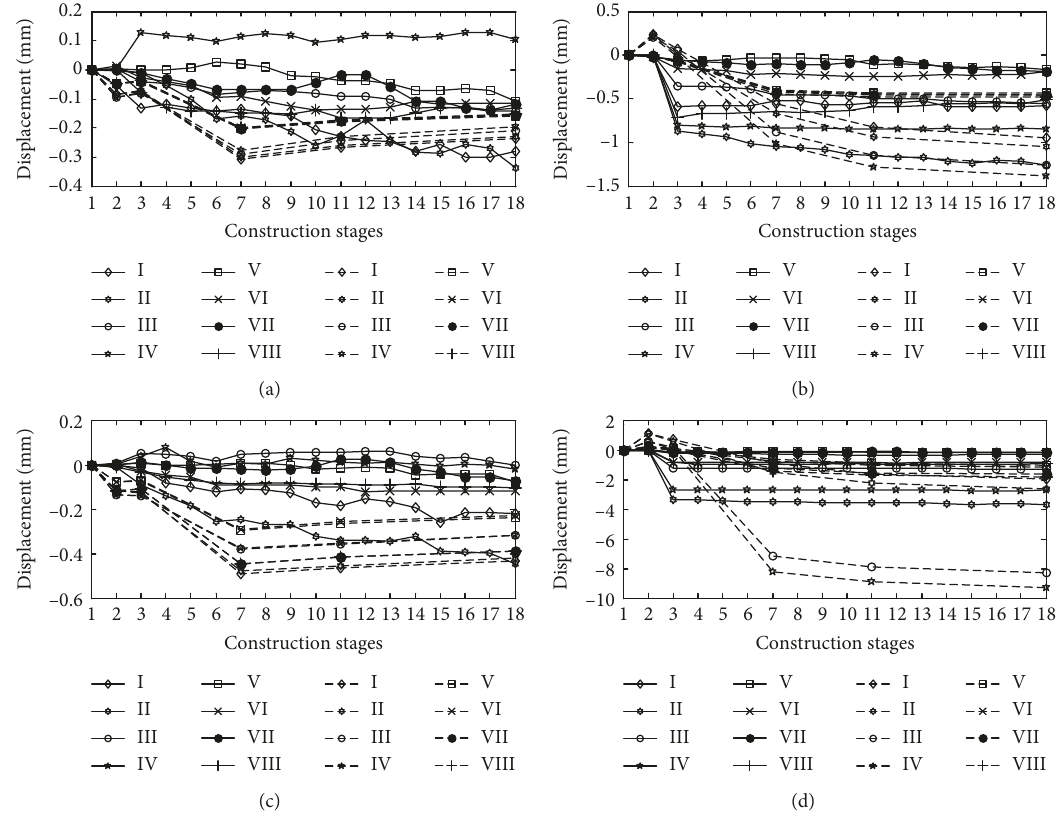
Figure 23: Comparison of vertical displacement of existing buildings between experimental and numerical results: (a) left building farthest from excavation; (b) left building nearest from excavation; (c) right building farthest from excavation; (d) right building nearest from